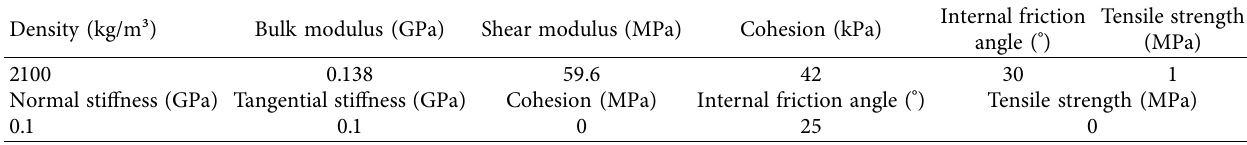
Table 2: Mechanical parameters of main rock mass and joint.